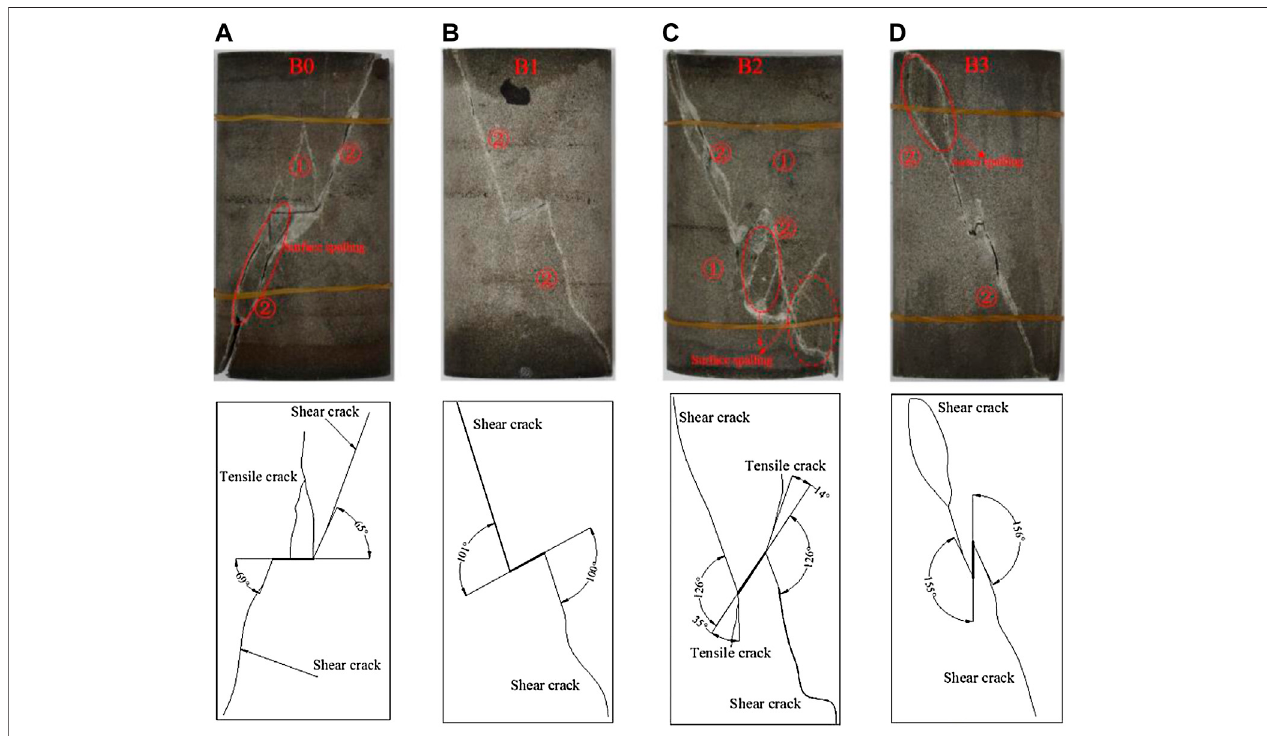
FIGURE 6 | Failure modes of sandstone samples with a single crack length of 15 mm and crack angles of (A) B0, 0 ° , (B) B1, 30 ° , (C) B2, 60 ° , and (D) B3, 90 ° .